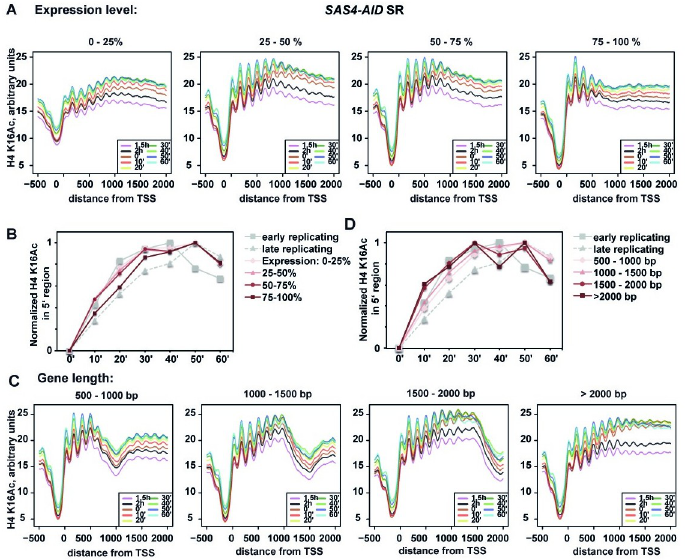
Fig 5. Dynamics of H4 K16Ac on genes of varying expression level. (A) The average H4 K16Ac in the expression clusters is plotted relative to the distance to the transcription start site (TSS). Genes were grouped into clusters based on gene expression in HU-arrested cells (0–25%, lowest expression; 75–100%, highest expression). (B) Genes with high expression showed a delay in replication-mediated increase of H4 K16Ac. H4 K16Ac was averaged across the genes of the cluster, but excluding the first 350 bp. Signals were adjusted to the same dynamic range. (C, D) Replication- associated increase of H4 K16Ac is more prominent in long compared to short genes. (C) Profiles were generated as in A, except that genes were selected by length (500–1000 bp; 1000–1500 bp; 1500–2000 bp; > 2000 bp). (D) Increase of H4 K16Ac during replication occurs earlier on longer compared to shorter genes. Representation as in